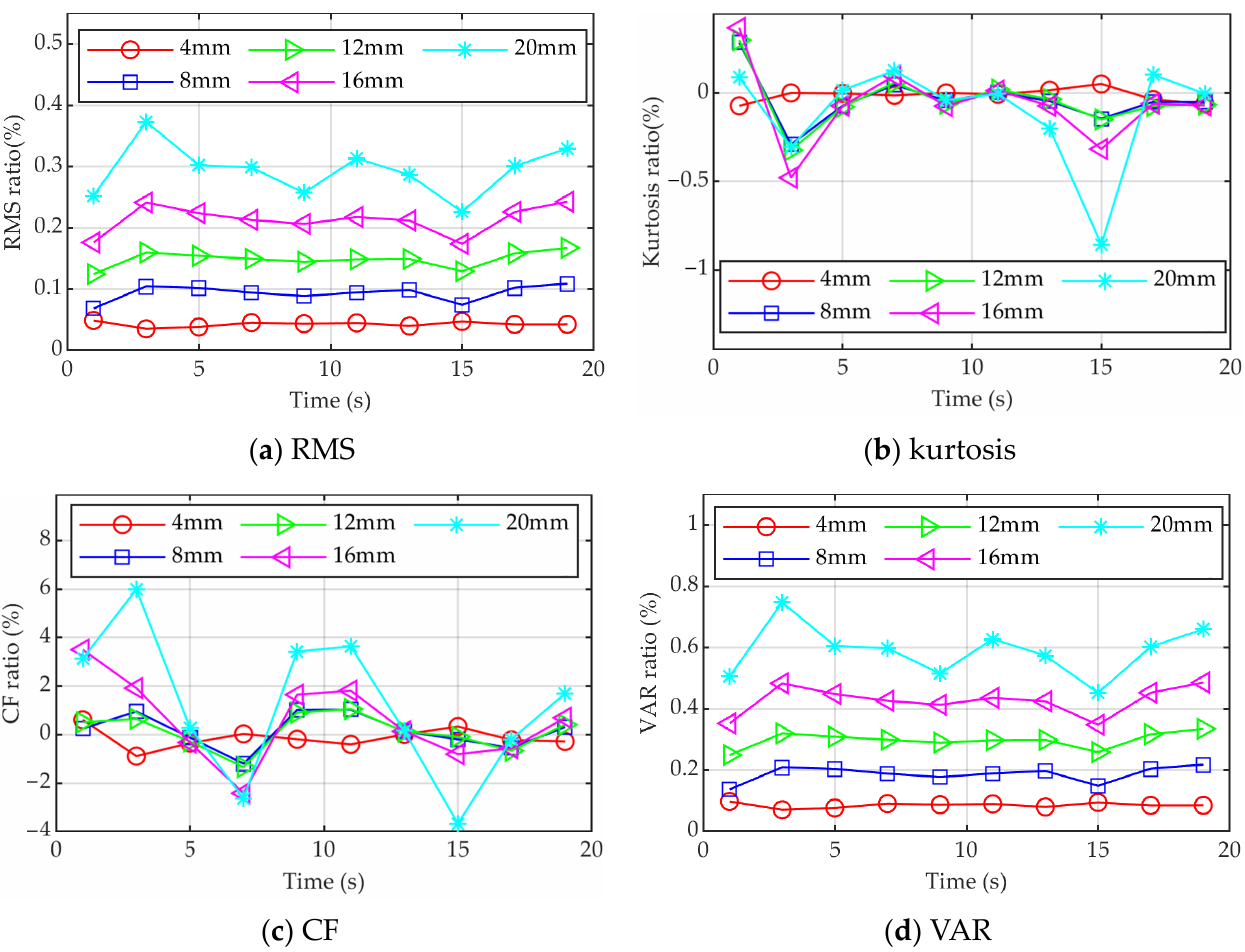
Figure 14. The variation of vertical vibration indicators of the fi rst gearbox housing after fi ltering.